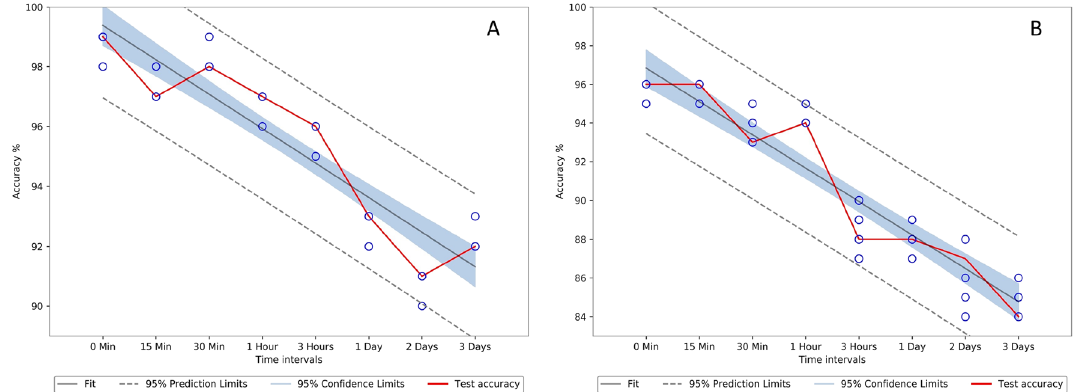
Figure 8. Paper3 confidence interval (CI) plot for beverage classification, ( A ) represents CI for SVM only and ( B ) represents CI for SVM with